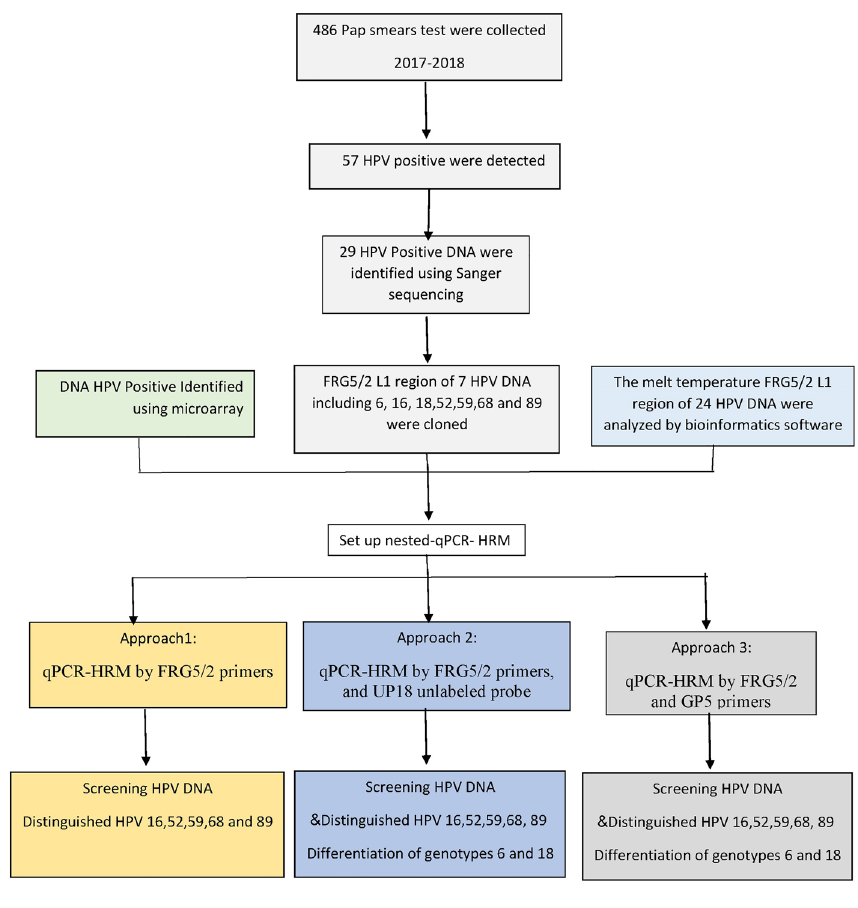
Figure 9. Flowchart of the study